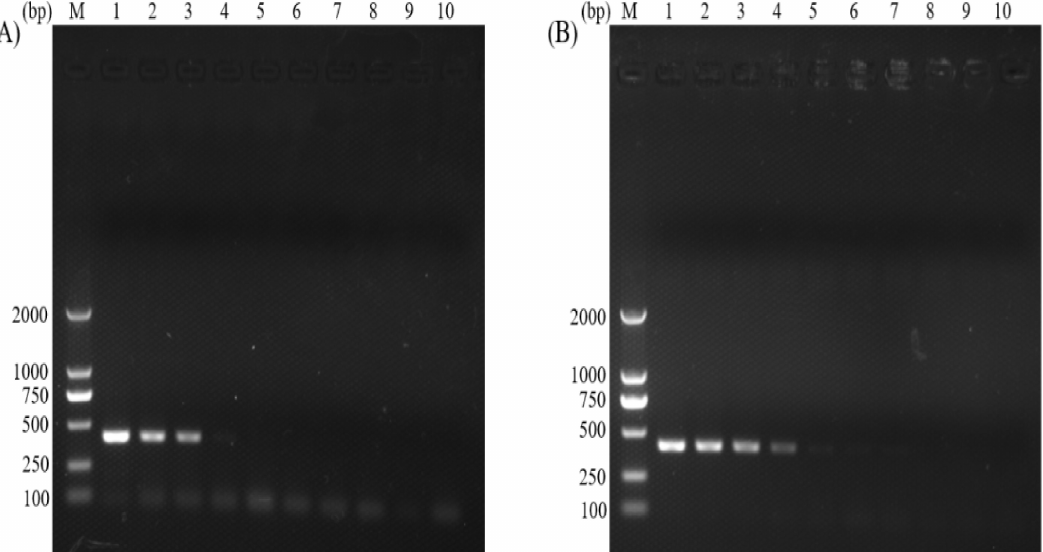
Figure 3. A serial ten-fold dilution of gDNA samples from C. parvum oocysts was used to analyze sensitivities of the normal PCR ( A ) and the nano-PCR ( B ) assays. Lane M: DL2000 DNA Marker (TakaRa); lane 1: 102 ng; lane 2: 10.2 ng; lane 3: 1.02 ng; lane 4: 102 pg; lane 5: 10.2 pg; lane 6: 1.02 pg; lane 7: 102 fg; lane 8: 10.2 fg; lane 9: 1.02 fg; lane 10: negative control.